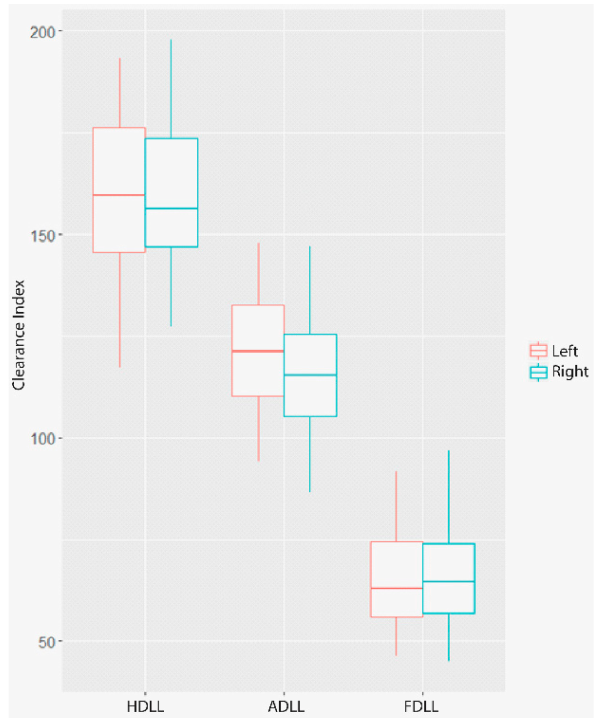
Figure 2. A boxplot representation of the differences (in mm) between maximal DLLs throughout the stance phase and the contralateral minimal DLLs throughout the swing phase among 40 healthy controls from prior analysis made in the same gait